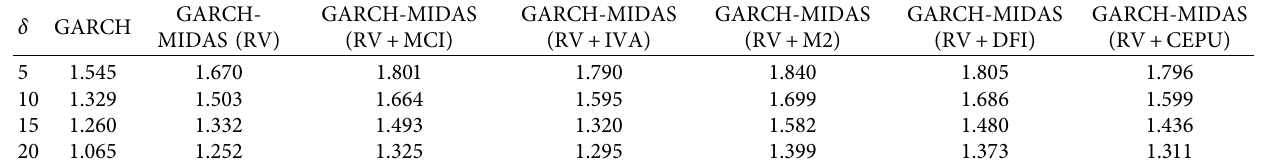
Table 5: Investment performance of different models based on RV.